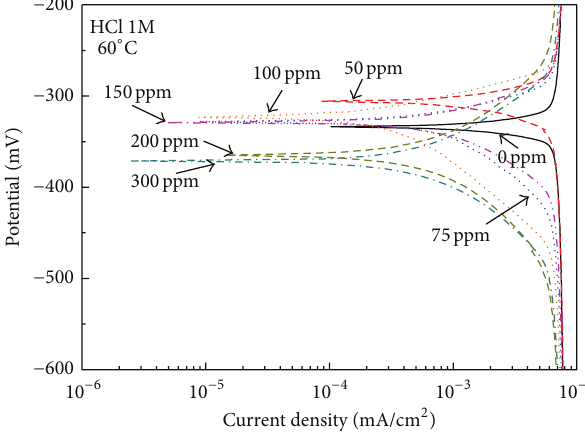
Figure 5: Effect of Opuntia ficus-indica concentration on the polar- ization curves for carbon steel in 1M HCl at 60 ∘